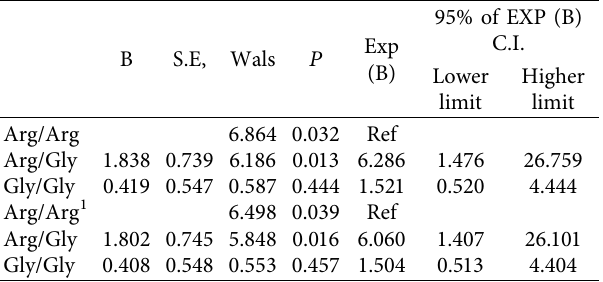
Table 3: Correlation between rs 1042713 and acute exacerbation of the chronic obstructive pulmonary